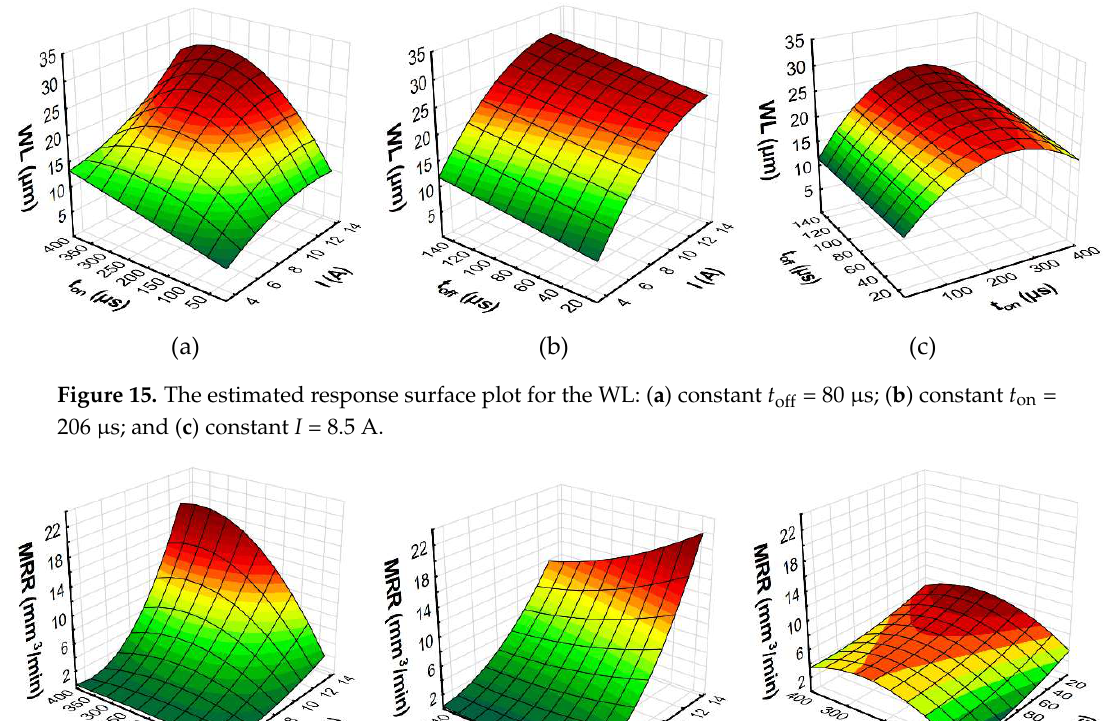
Figure 14. The estimated response surface plot for roughness ( Sa) : ( a ) constant t off = 80 μs; ( b ) constant t on = 206 μs; and ( c ) constant I = 8.5 A.